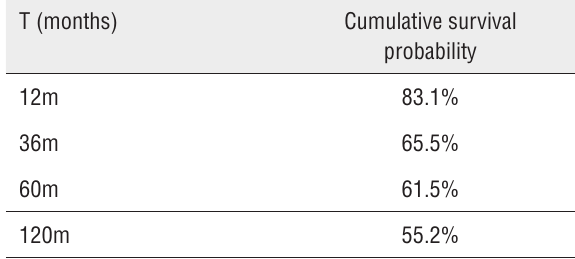
Table 2 - Mean PFS in the whole series.